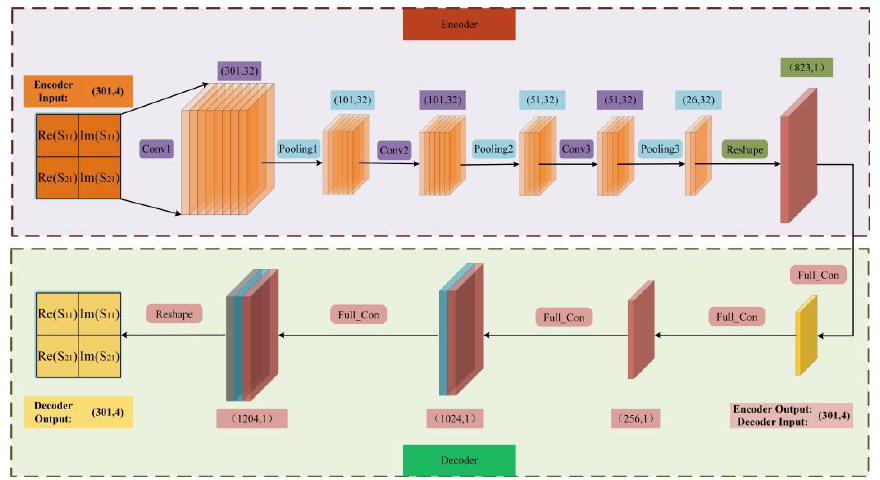
Figure 6. Network structure of the AOU-1D-CAE.